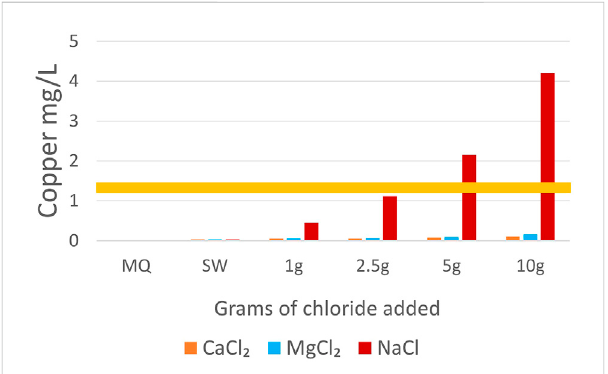
FIGURE 7 Comparison of Cu mobilized by different salt